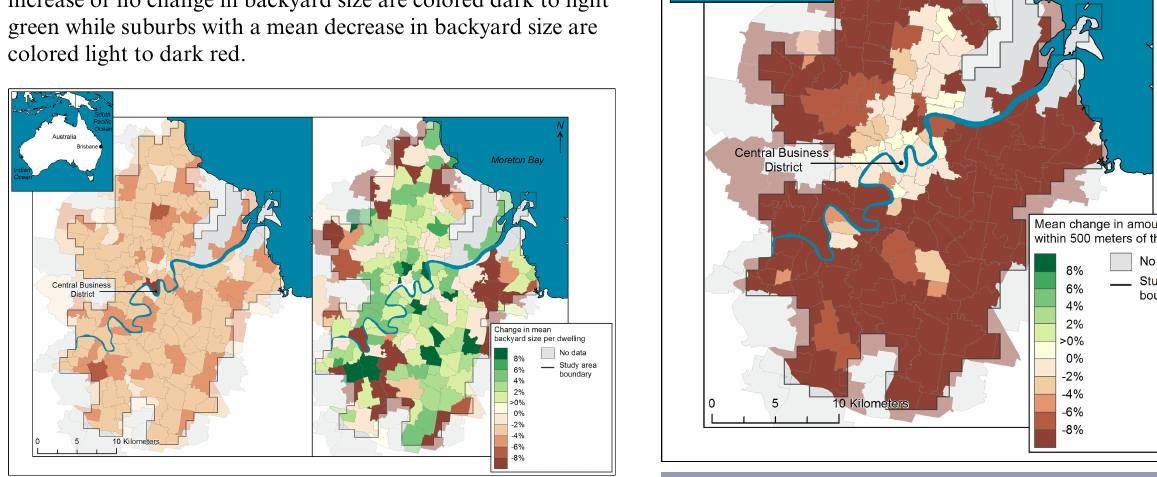
in declines in average backyard size per dwelling across the entire city the declines were smaller in magnitude and more evenly distributed across the city than with sprawling development (Fig. 2).